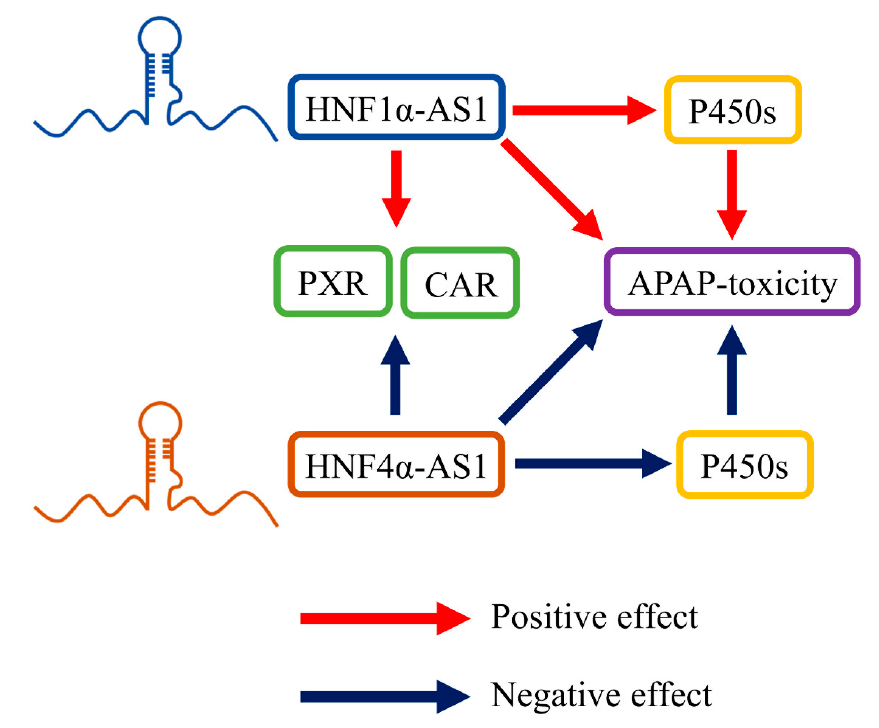
Figure 6. HNF1 α -AS1 and HNF4 α -AS1 in hepatic metabolism. HNF1 α -AS1 is able to